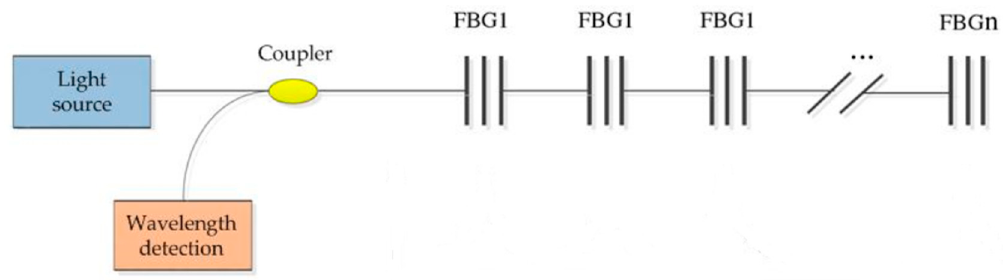
Figure 9. Schematic diagram of wavelength division multiplexing technology.